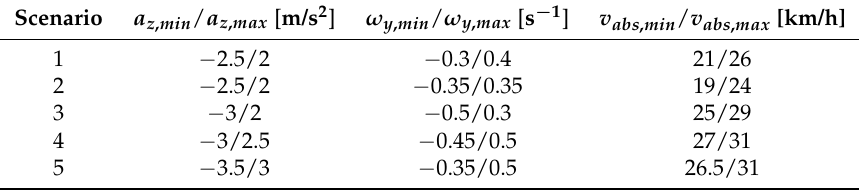
Table 2. Parameterization of 5 road bump scenarios for the vehicle dynamics model validation.